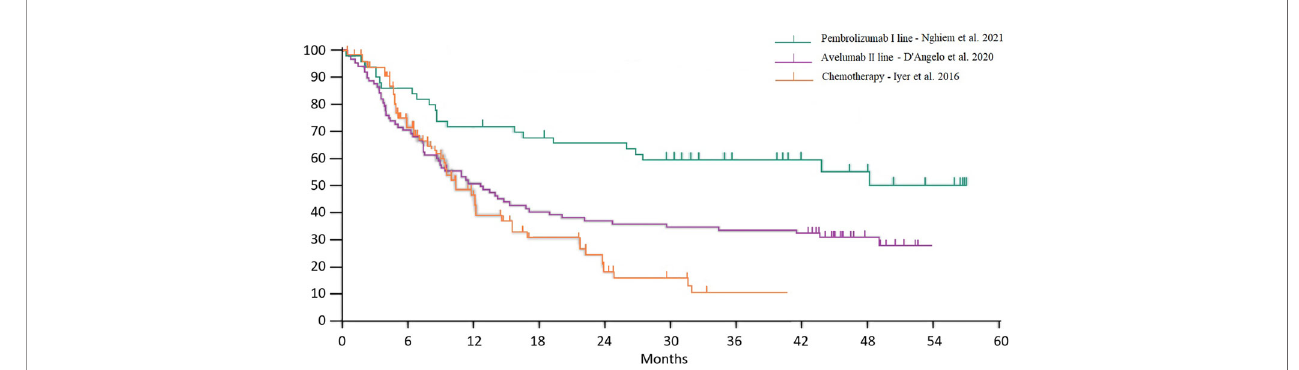
FIGURE 2 | Historical comparison between chemotherapy and immunotherapy overall